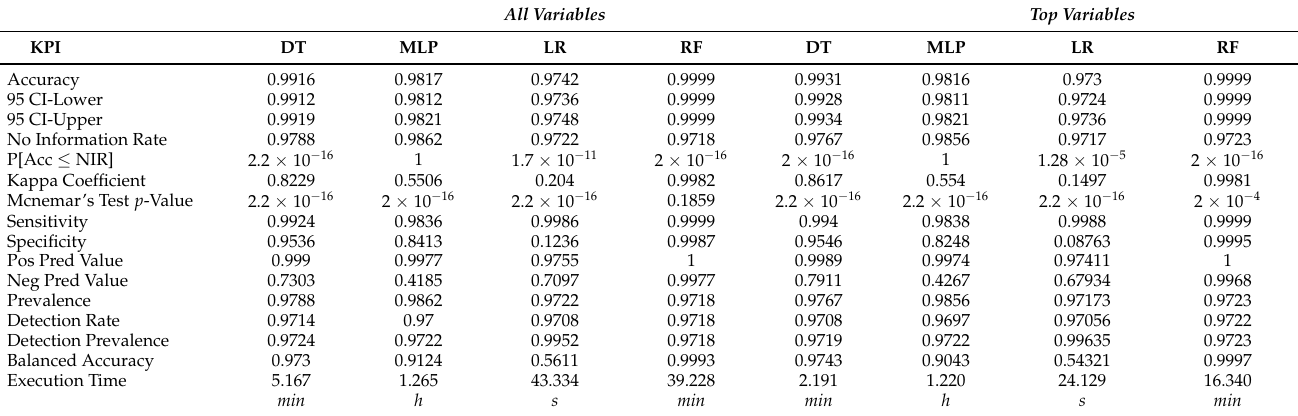
Table 9. Methods Comparison by Key Performance Indicators: Alarm Prediction in 48 h. All